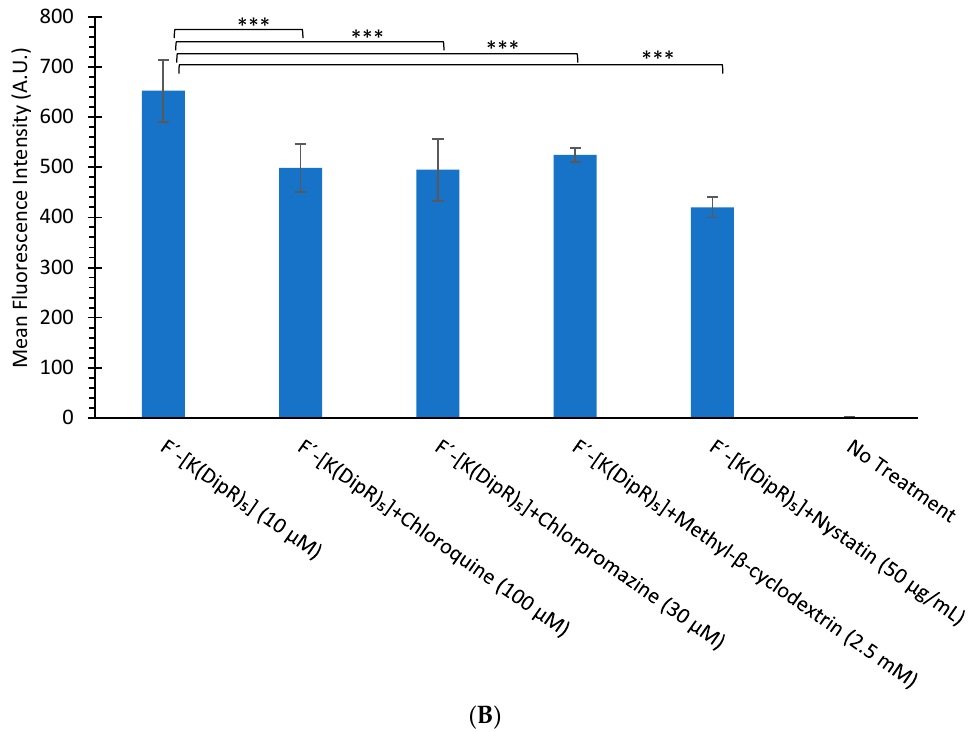
Figure 11. ( A ) The cellular uptake study of F’-GpYEEI (2 µM) in the presence of [DipR] 5 (10 µM) and endocytosis inhibitors in CCRF-CEM cells after 3 h incubation. ( B ) The cellular uptake study of F’-[K(DipR) 5 ] (10 µM) and endocytosis inhibitors in CCRF-CEM cells after 3 h incubation. Results are mean ± SD (n = 3) (*** p < 0.001).